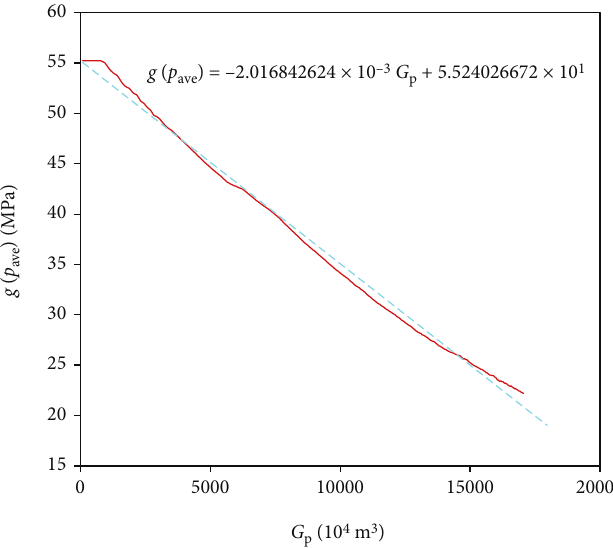
Þ to G for the gas well p ave